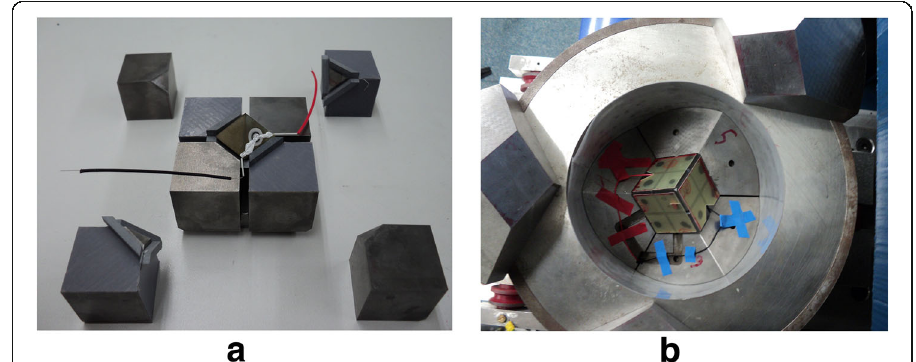
Fig. 2 The experimental setup: a the assembly within the eight tungsten inner anvils. b The pressure module with outer anvils surrounding the cube of inner